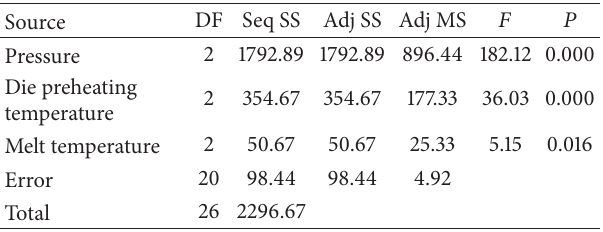
Table7:AnalysisofvarianceforhardnessusingadjustedSSfortests.